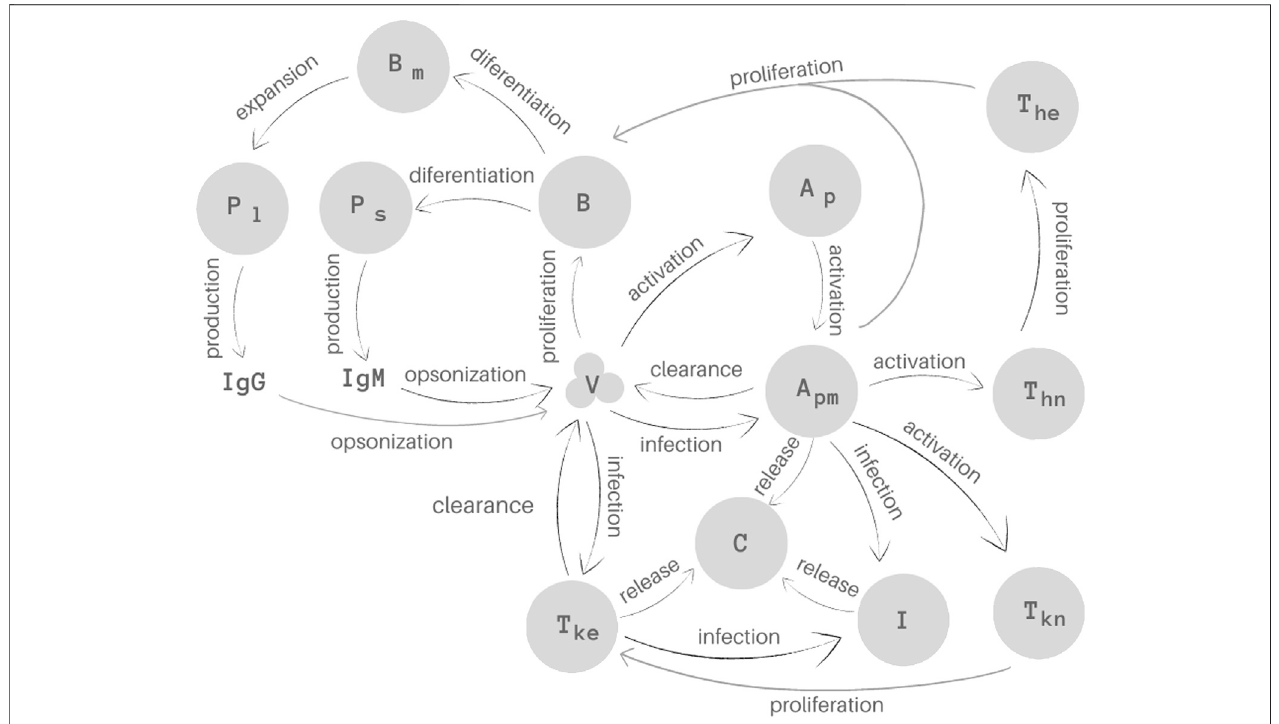
FIGURE1| Representationofthe15biologicalspeciesandtheirinteractionsasconsideredinthemathematicalmodel.HomeostasisisnotillustratedinthisFigure.